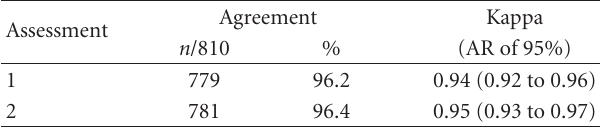
Table 7: Evaluation of agreement between observers (interob- server) for each evaluation, in the study of loci